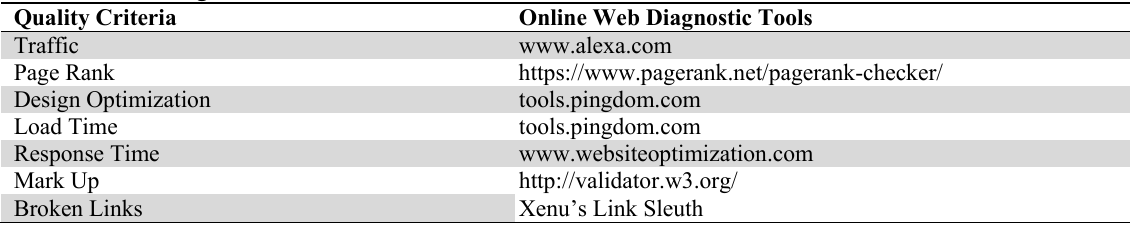
Online Web- Diagnostic Tools for Data Collection Quality